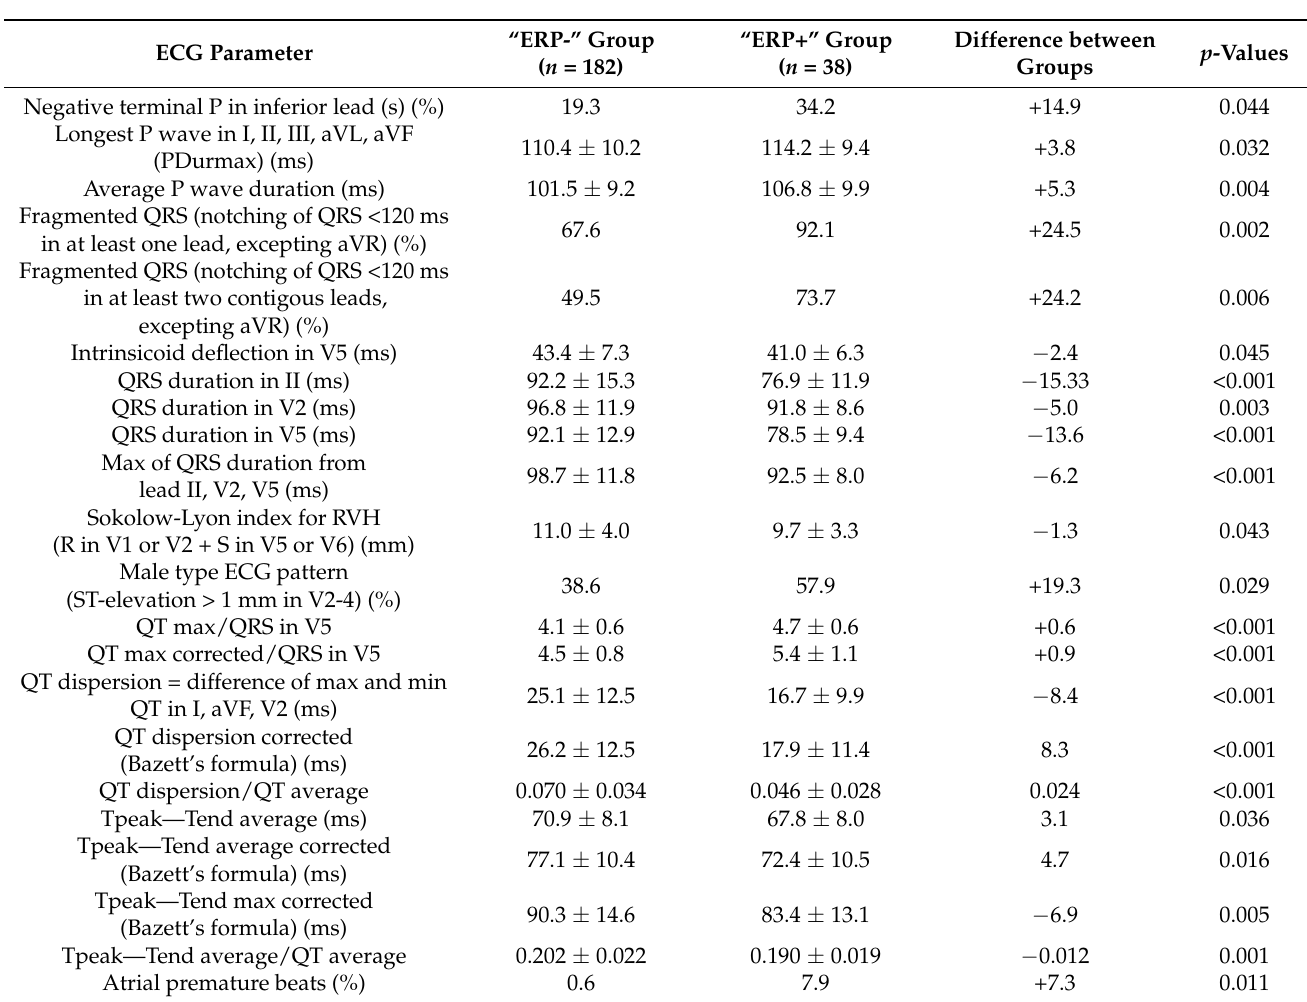
Table 2. The significant differences found by comparing ECG parameters of subjects without (“ERP-”) and with (“ERP+”)